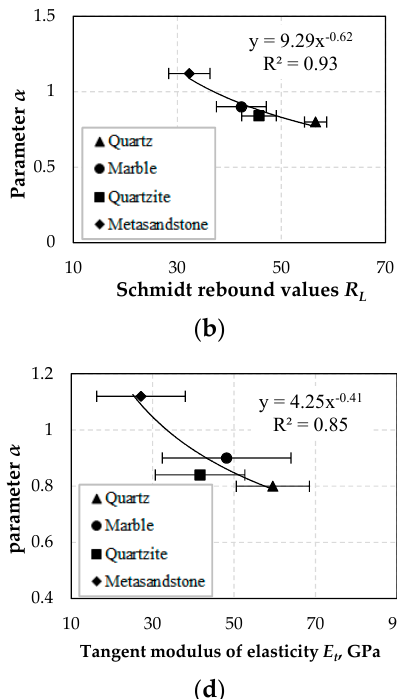
Figure 11. Correlations between parameter α Τ and ( a ) P-wave velocity V p , ( b ) Schmidt rebound values R L , ( c ) uniaxial compressive strength UCS and ( d ) tangent modulus of elasticity E t ; horizontal error bars show standard deviation of the measurements.